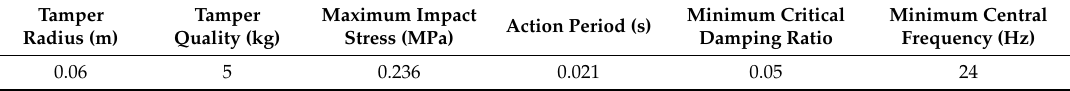
Table 10. Parameters of dynamic